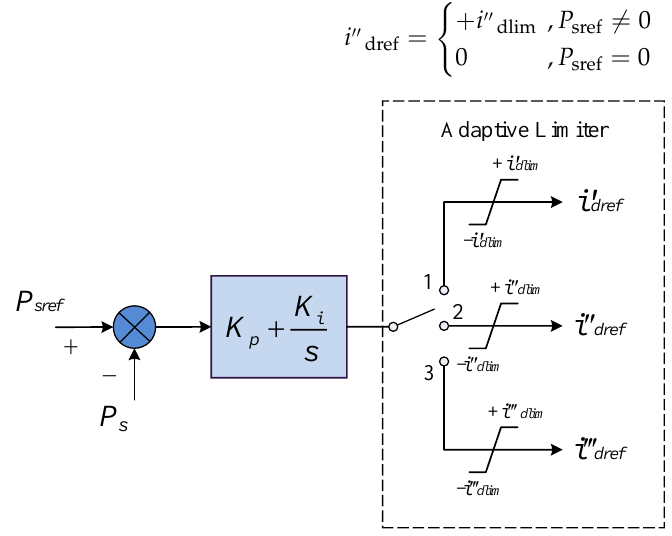
Figure 7. The structure of the adaptive limiter.